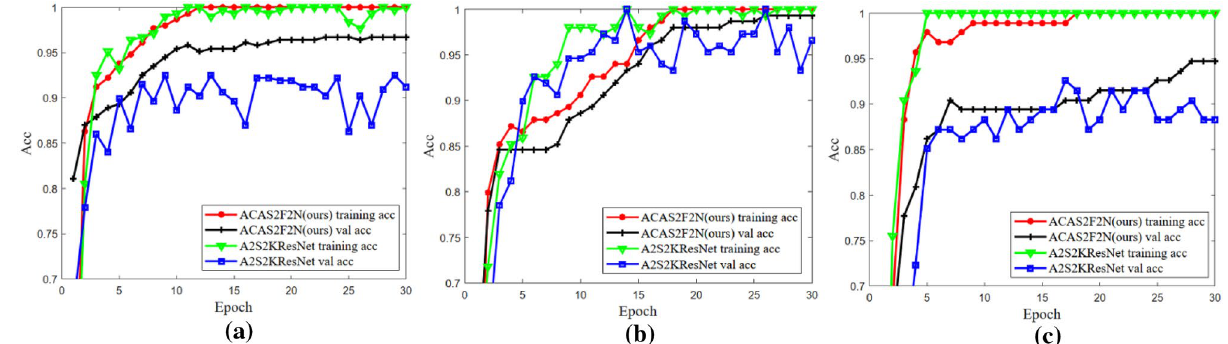
Figure 12. Training and verification accuracy. ( a ) IP dataset. ( b ) KSC dataset. ( c ) Botswana